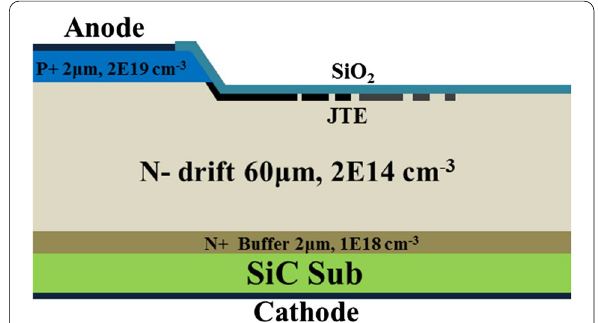
Fig.1 Schematic cross section of 4H-SiC PiN diodes